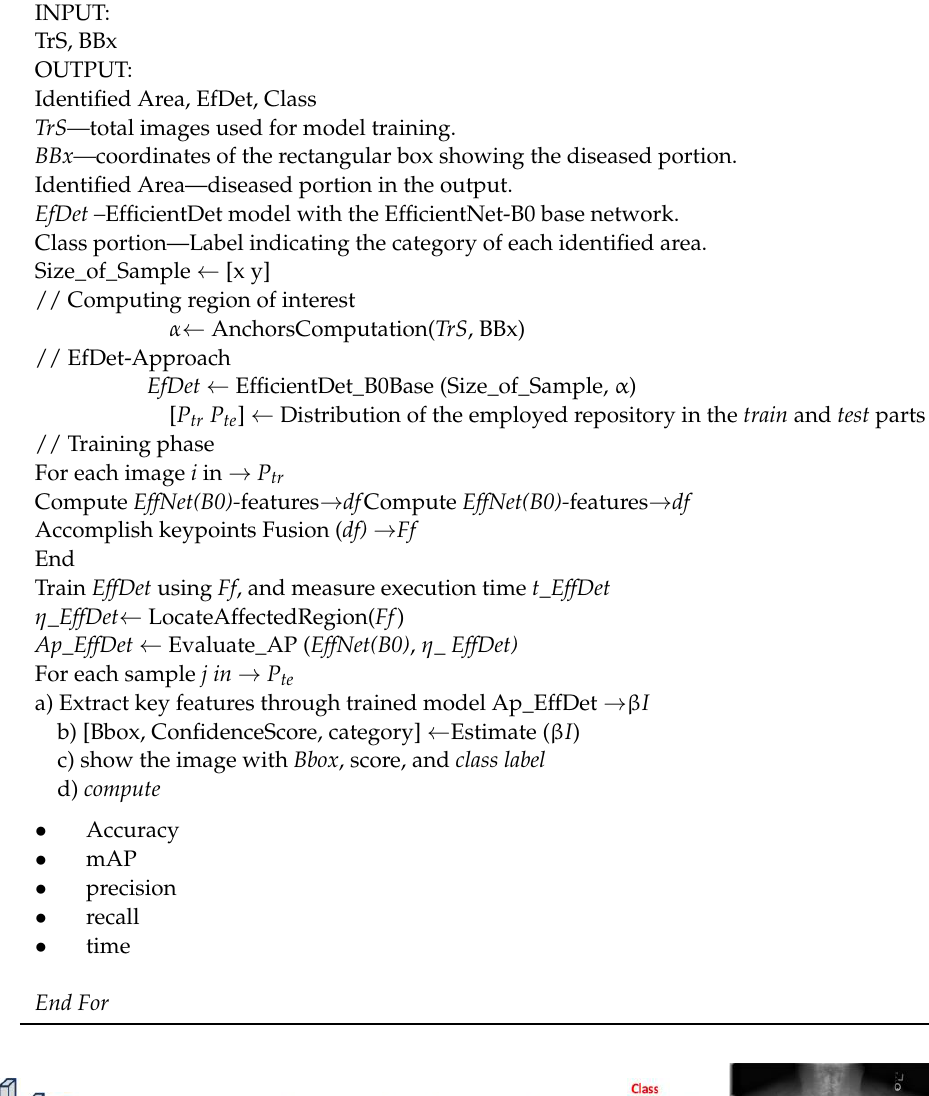
Algorithm 1: Infected Region Detection